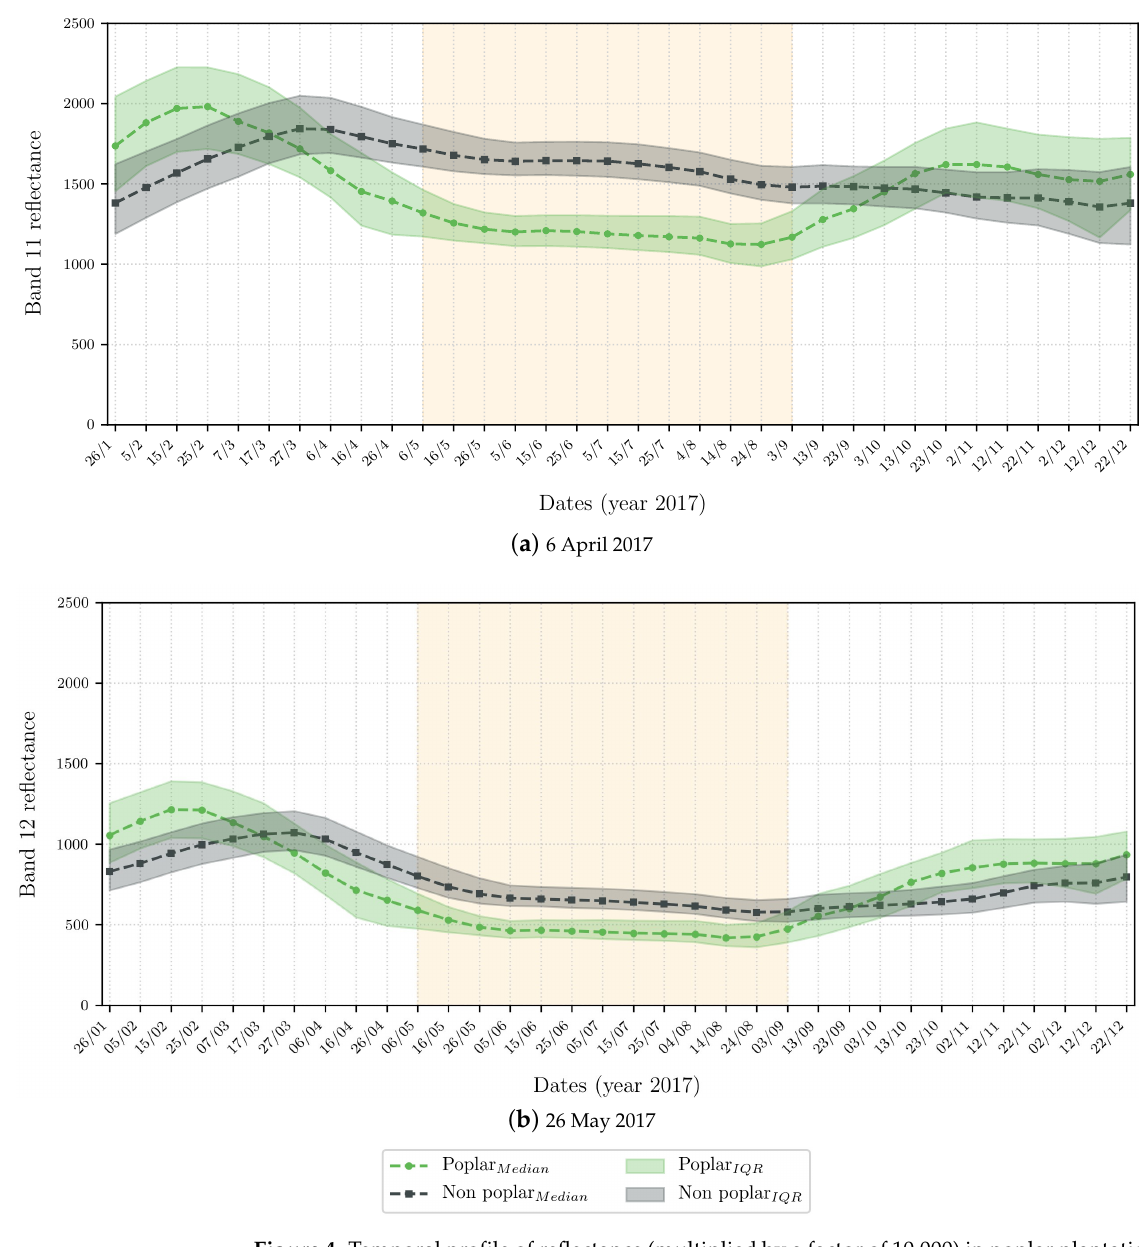
Figure 4. Temporal profile of reflectance (multiplied by a factor of 10,000) in poplar plantations versus deciduous tree species in 2017 for ( a ) band 11 and ( b ) band 12. The dashed lines represent the median signal, and the surrounding shaded areas represent the interquartile range, in green for poplar and in grey for the other deciduous species. The pale yellow box highlights the most discriminating spring–summer period for